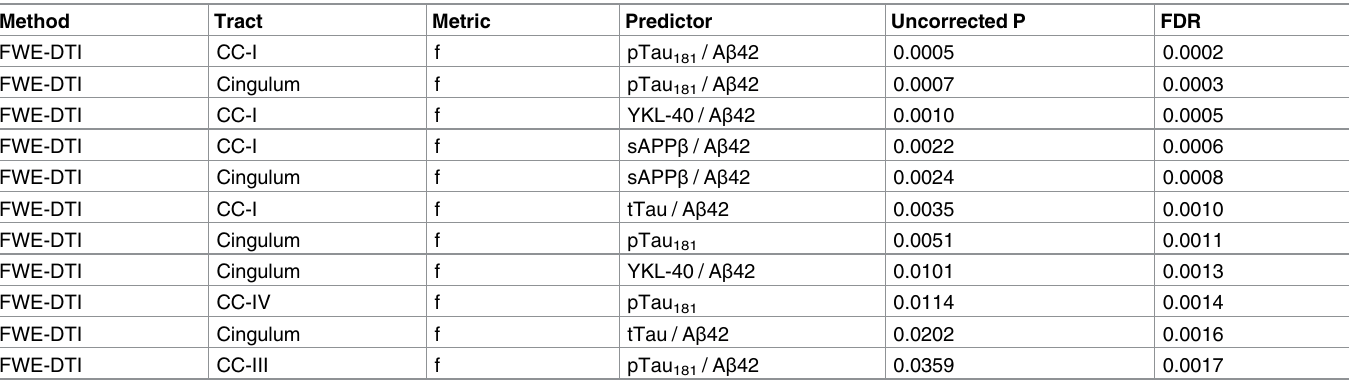
Table 5. FWE-DTI tractography